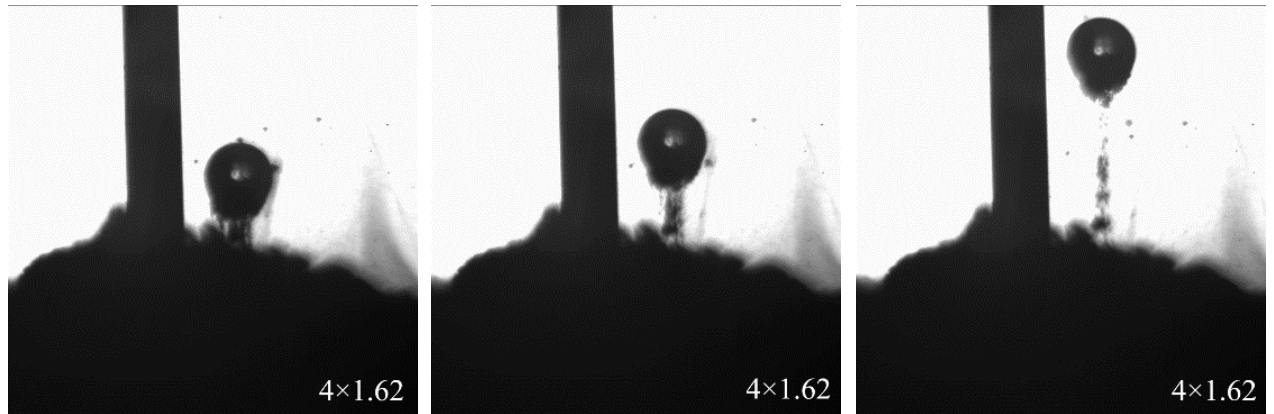
Figure 9. Contact of bubbles and mineral particles.